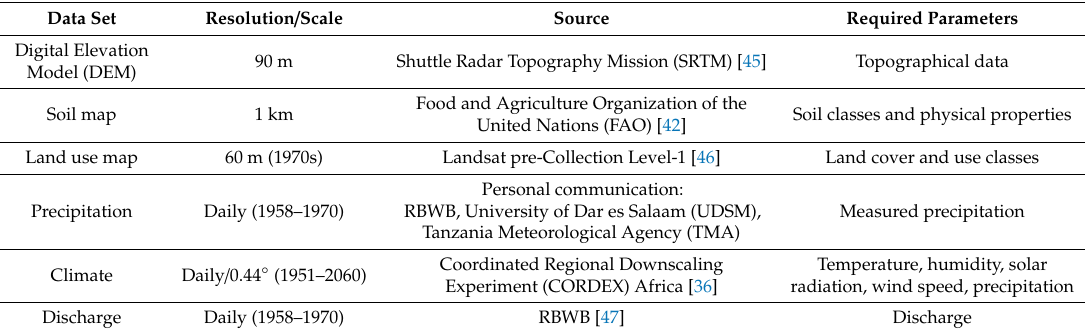
Table 1. Overview of the applied datasets, their resolution, sources, and the required parameters in this study.